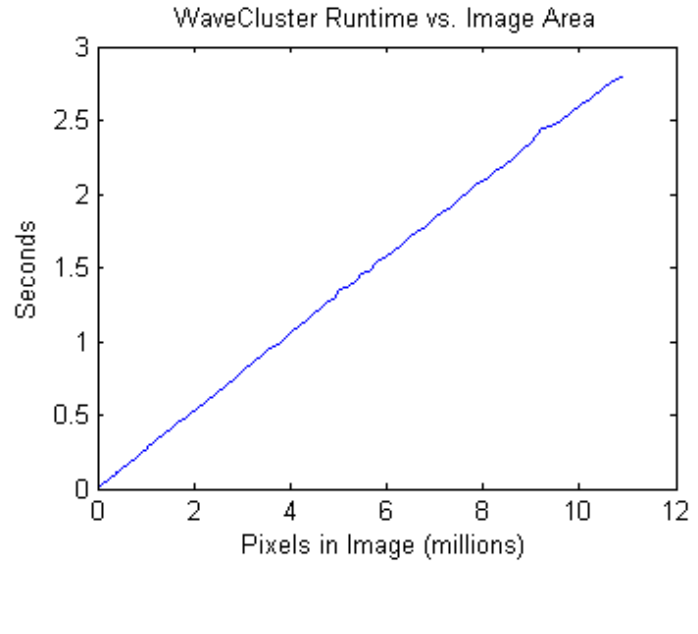
Figure 5. Runtime of WaveCluster as a function of image size.